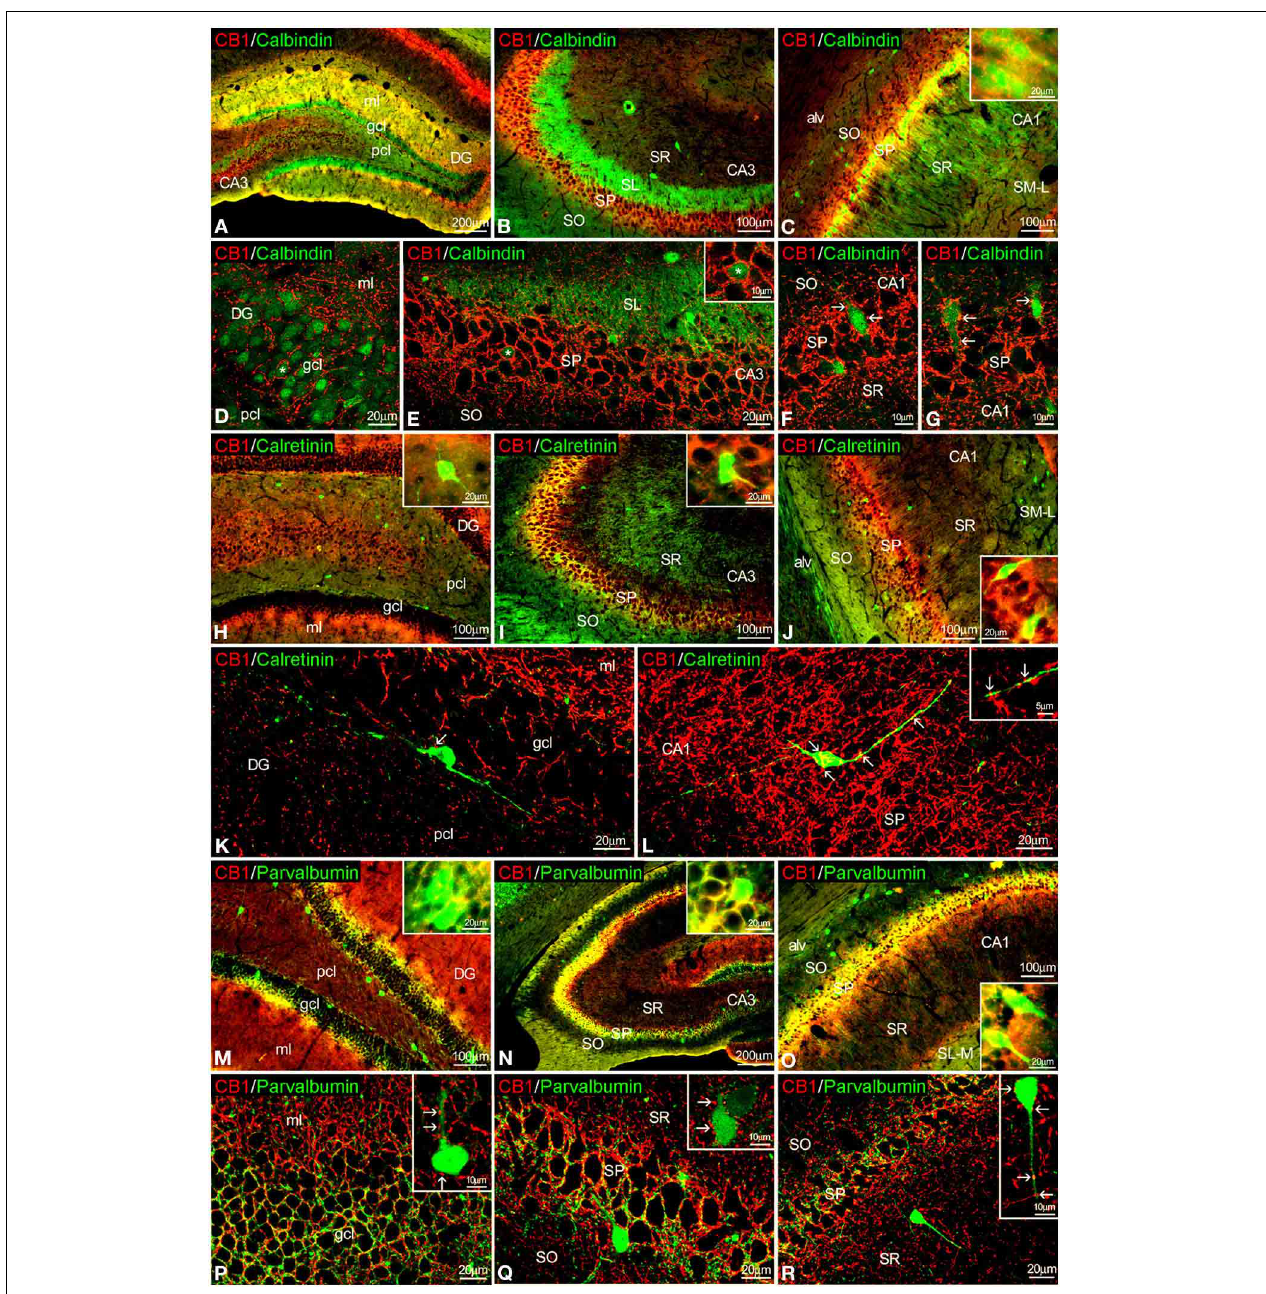
FIGURE 3 | Co-localization of CB 1 and calbindin, calretinin, or parvalbumin in the rat hippocampus. Low resolution epifluorescence photomicrographs (A–C,H–J,M–O) and high resolution confocal laser scanning photomicrographs (D–G,J–L,P–R) showing labeling for calbindin, calretinin, or parvalbumin (green) and CB 1 (red) in dentate